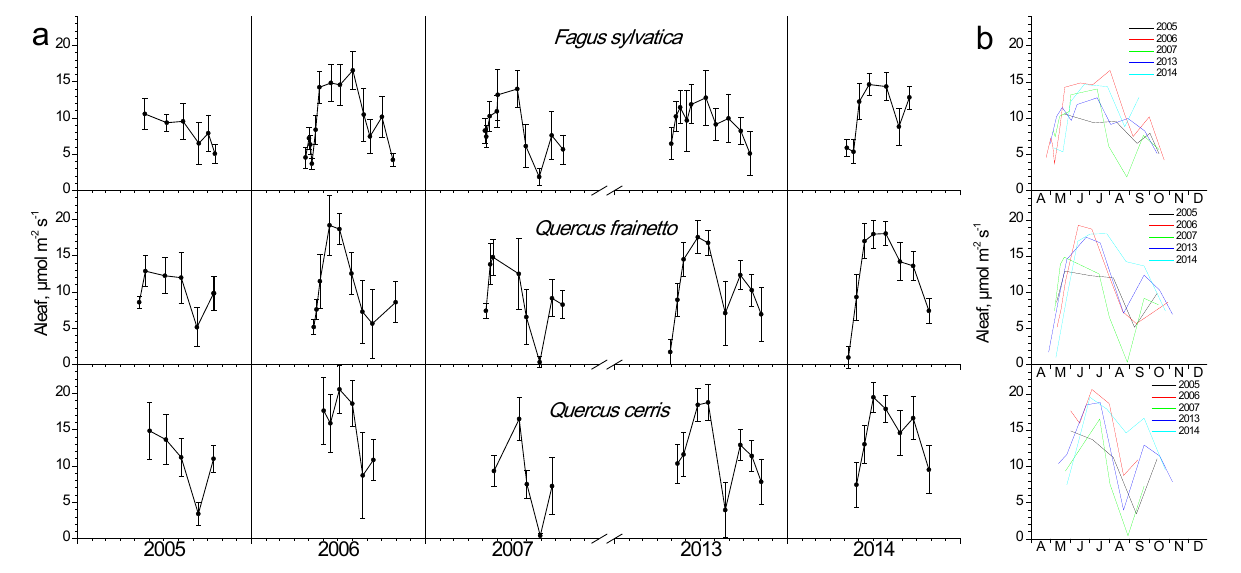
Figure 7. Seasonal fluctuation of leaf photosynthesis (Aleaf) for the three studied species. ( a ) Data for each year separately (average values ± SD for each date) ( b ) data for all years (only average values per date, error bars are not shown for clarity reasons).